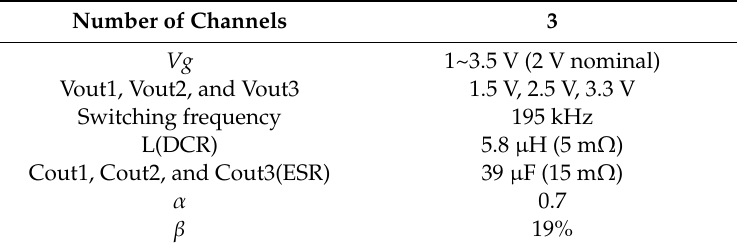
Figure 12. Measured waveforms of output voltages and gate-drive signal on switch S E while the sampled is sensed to be between and where = 2 V, = 100 mA, = 104 mA, and = 53 mA. Table 2. Specifications and component values of the proposed converter.